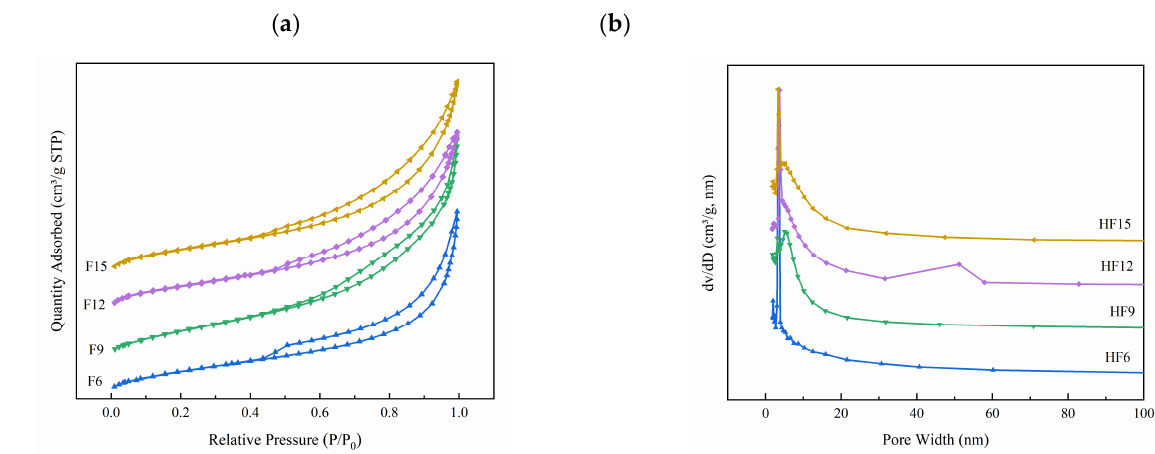
Figure 4. Nitrogen adsorption–desorption curve ( a ) particle size distribution ( b ) of FX. Table 2. Structural parameters of FX .